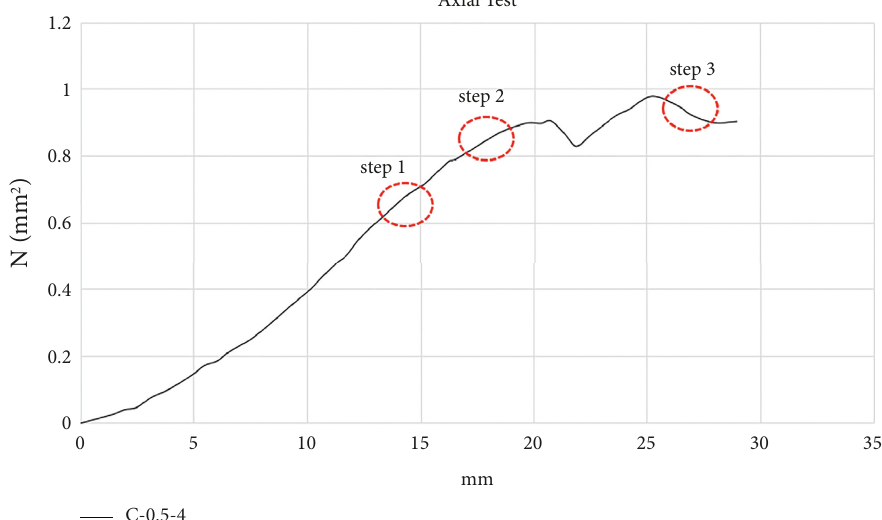
Figure 19: The tension-displacement chart for the C-0.5-4 panel in the axial test.